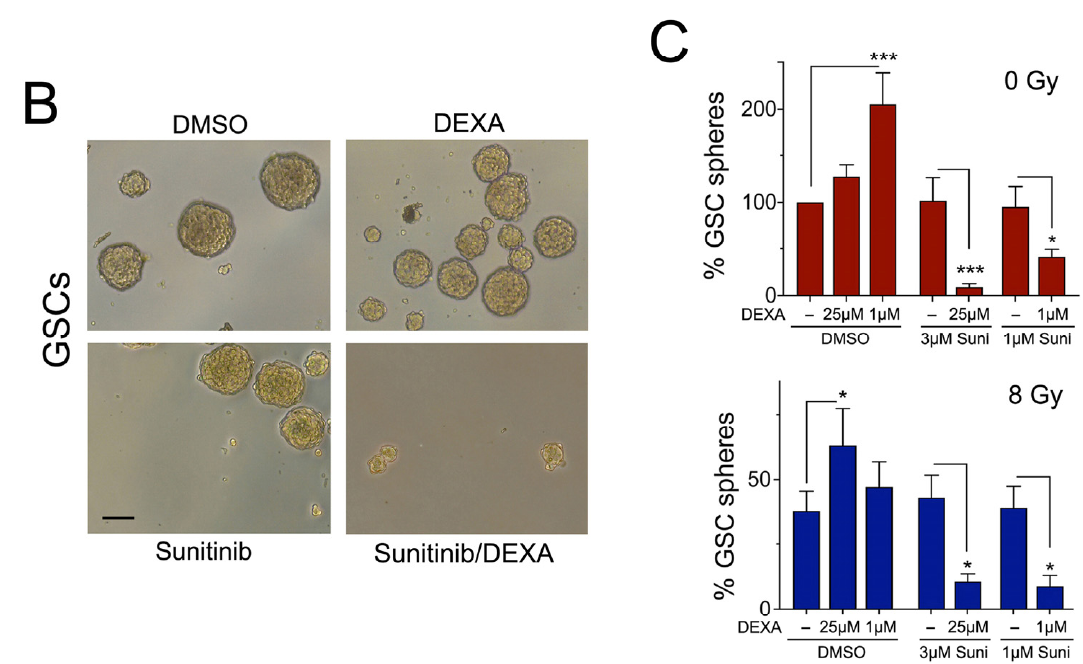
Figure 6. Dexamethasone sensitizes glioblastoma cells to sunitinib. ( A ) Quantification of cell numbers in T98G cells either non-radiated or radiated with 6 Gy in the absence or presence of DEXA and sunitinib. Data represent mean ± SEM ( n ≥ 3). ( B ) Images depicting neurospheres formed by GSCs under the indicated conditions. ( C ) Quantification of sphere formation by GSCs cultured in stem cell medium under non-adherent conditions either non-radiated or radiated with 8 Gy in the absence or presence of DEXA or sunitinib (Sun). Data represent mean ± SEM ( n ≥ 3). * p < 0.05, ** p < 0.01, *** p <